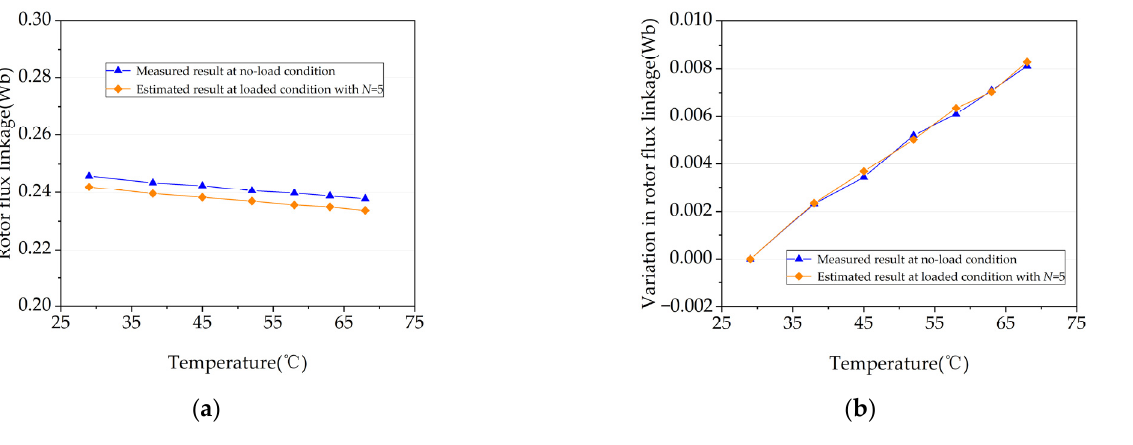
( c ) Figure 11. PMSM waveforms at free-running condition with different initial speeds. ( a ) 100 rpm. ( b ) 200 rpm. ( c ) 400 rpm.